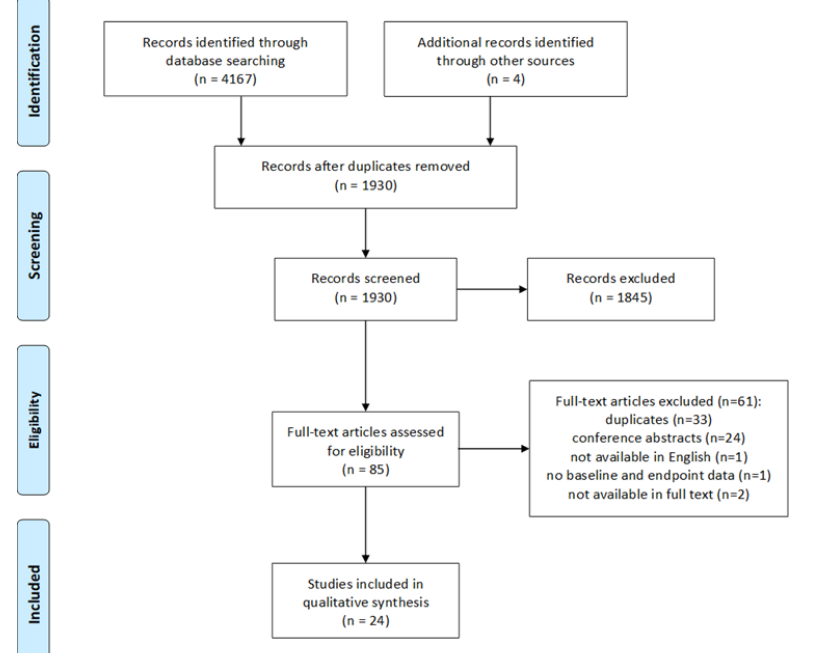
Figure 1. Process flow chart of the systematic literature search.